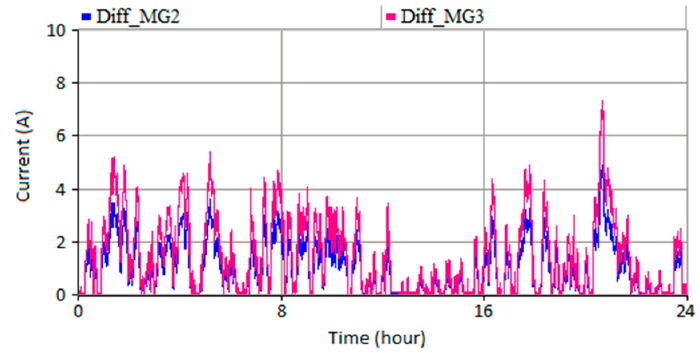
Figure 15. Neutral current changes for MG2 and MG3 in case Ac and Ab.